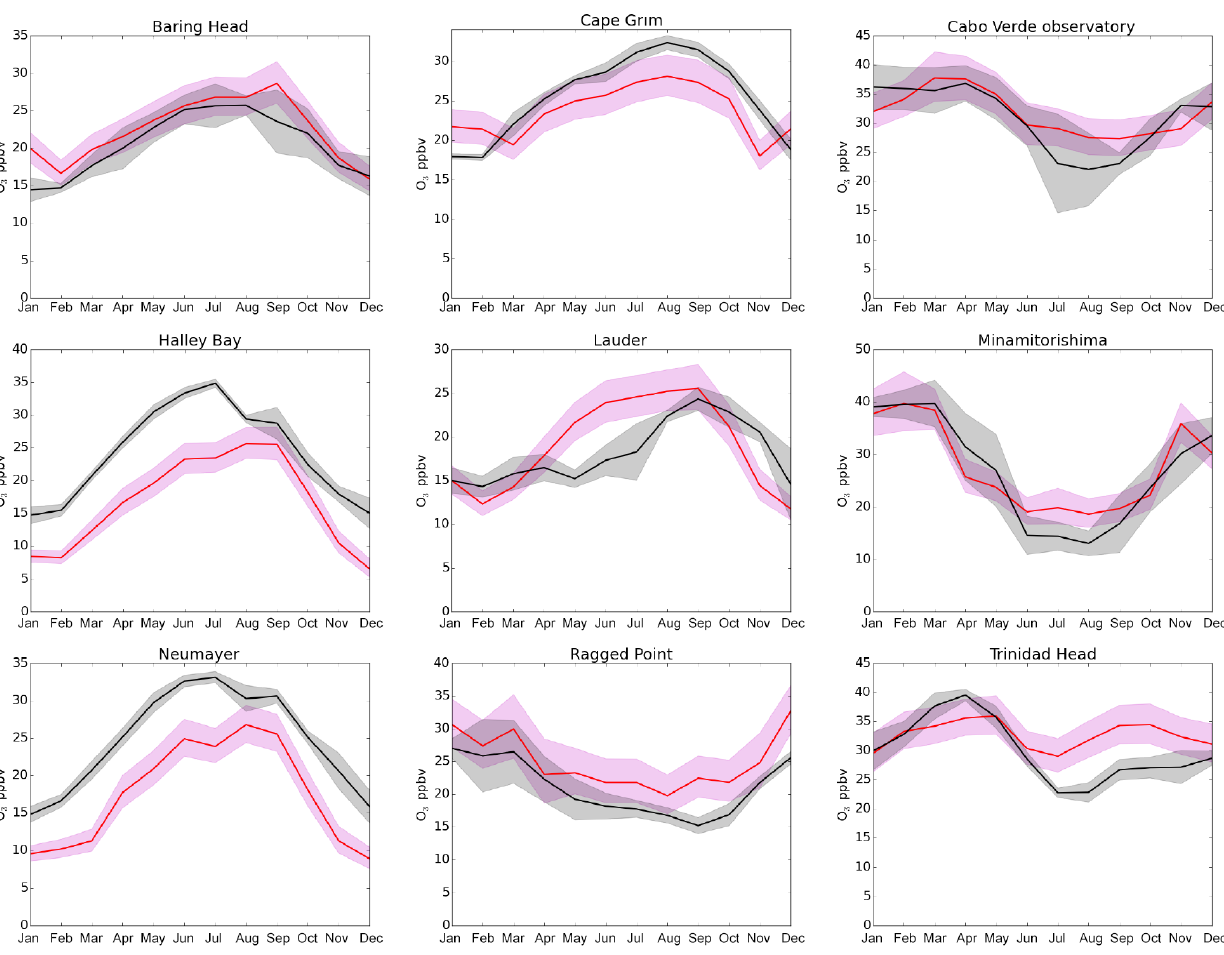
Figure 13. Ozone site comparison: modelled (red) and measured (black) concentrations of ozone at a range of sites. The pink shaded area shows the 1 σ uncertainty from the chemical kinetics. The error bars represent the 1 σ uncertainty of these observations. Monthly mean observational data were obtained from Sofen et al. (2016), using multiple years between 2004 and 2010 to create more complete